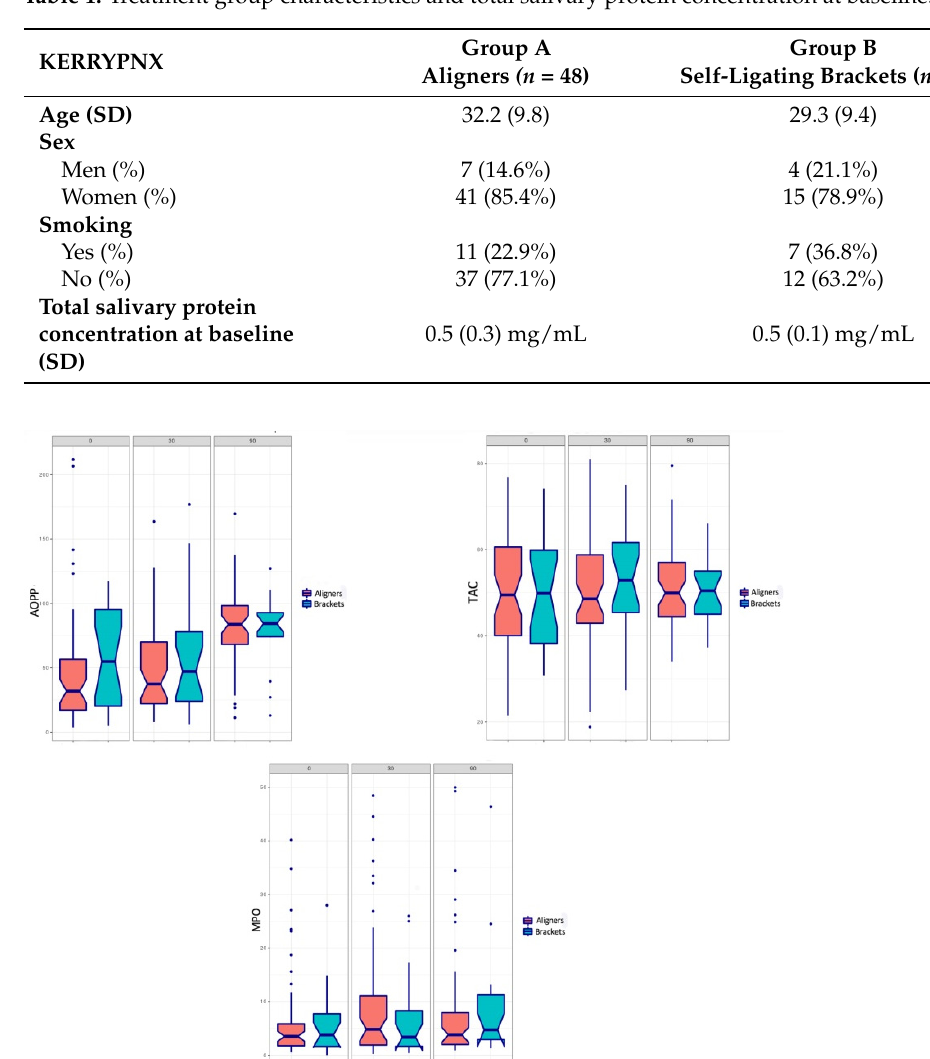
Table 1. Treatment group characteristics and total salivary protein concentration at baseline.